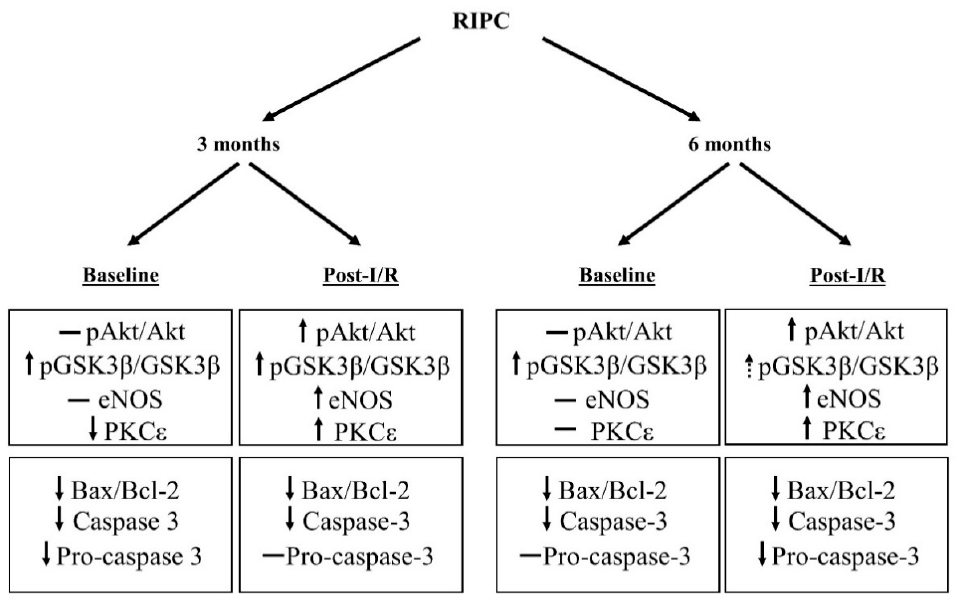
Figure 6. A schematic summary of the effects of RIPC on proteins of cell survival and pro/anti- apoptotic proteins under pre-ischemic baseline and post-I/R conditions in 3-month-old and 6-month-old male rats. Up arrow—significant increase, intermittent up arrow—trend to increase ( p = 0.067), down arrow—significant decrease, straight line—no significant change.